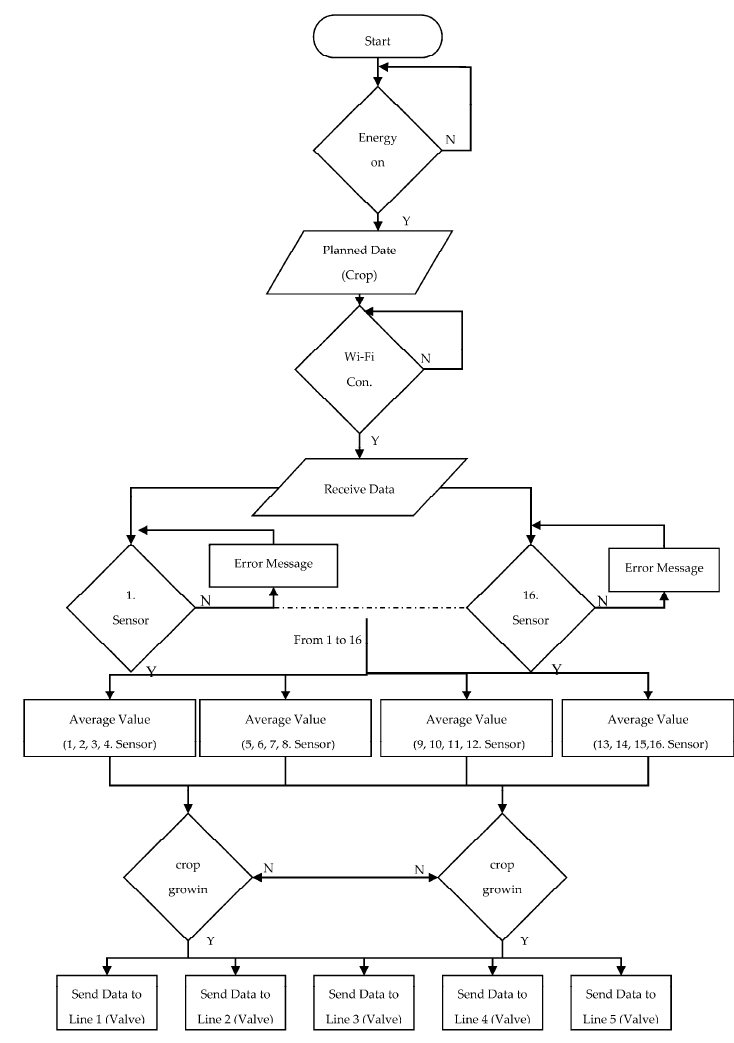
Figure 8. The flowchart of the software.